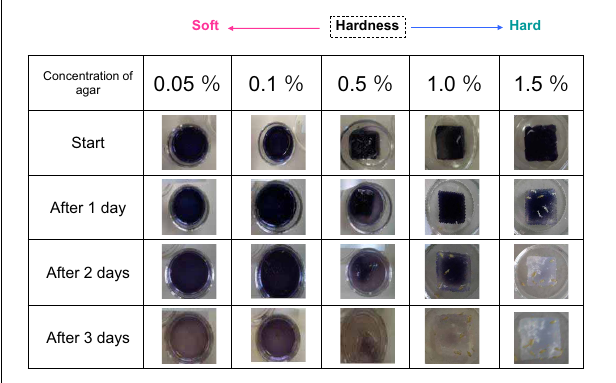
FIGURE 3 | Relationship between agar cube hardness and the amount of amylase excreted. Gels containing different amounts of agar (0.05–1.5%) were used in ISAM. The color fading of each gel was examined for 3 days and photographed. The color of harder gels faded more rapidly, indicating that larvae excreted more saliva on harder